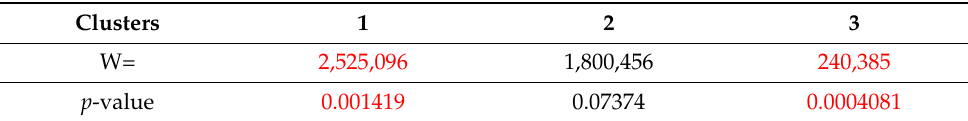
Table 4. Wilcoxon rank-sum test of the shift parameter for frequency ( α = Table 3. Descriptive statistics of the frequency at the tested measuring point.